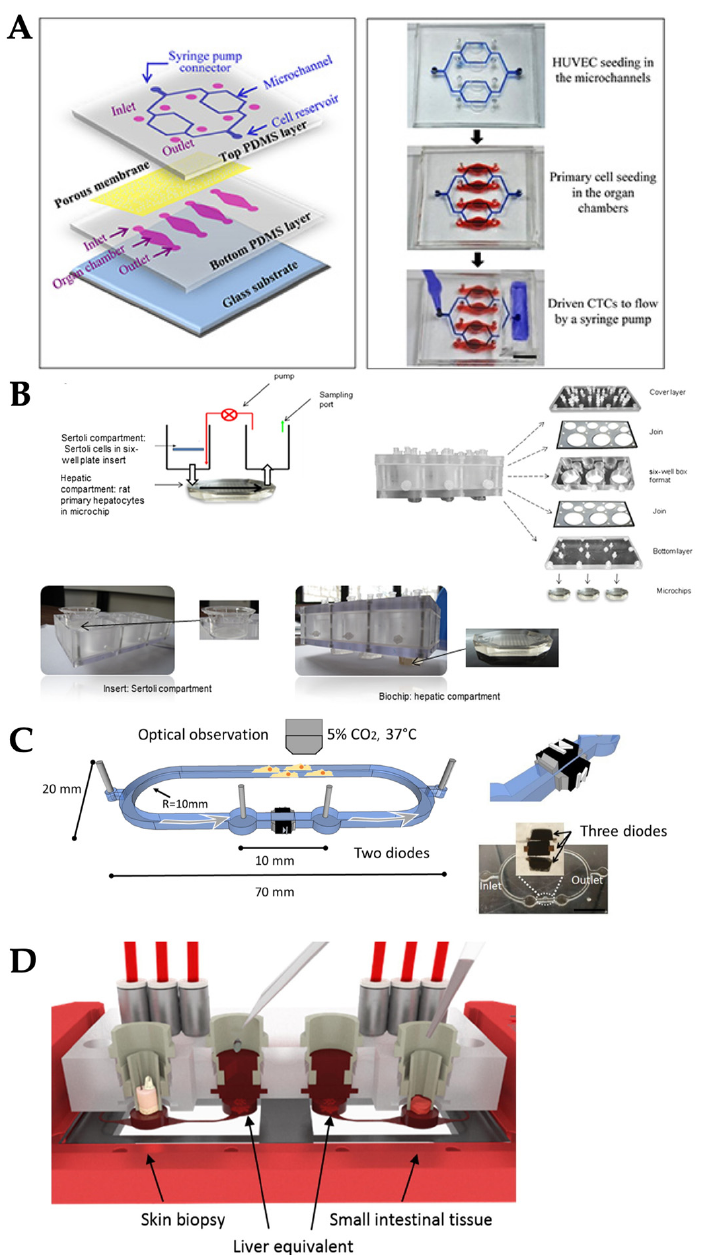
Figure 4. Examples of OOC systems with external and internal pumping. ( A ) External syringe pump for the OOC with endothelial cells. ( B ) External peristaltic pump for the OOC with hepatocytes and Sertoli cells. ( C ) Electro-osmosis (EOS) pumping was integrated onto the OOC with human lung cancer cells. ( D ) A peristaltic valve was integrated onto the OOC with liver-intestine and liver-skin cells. Reproduced with permission from References [49–52].